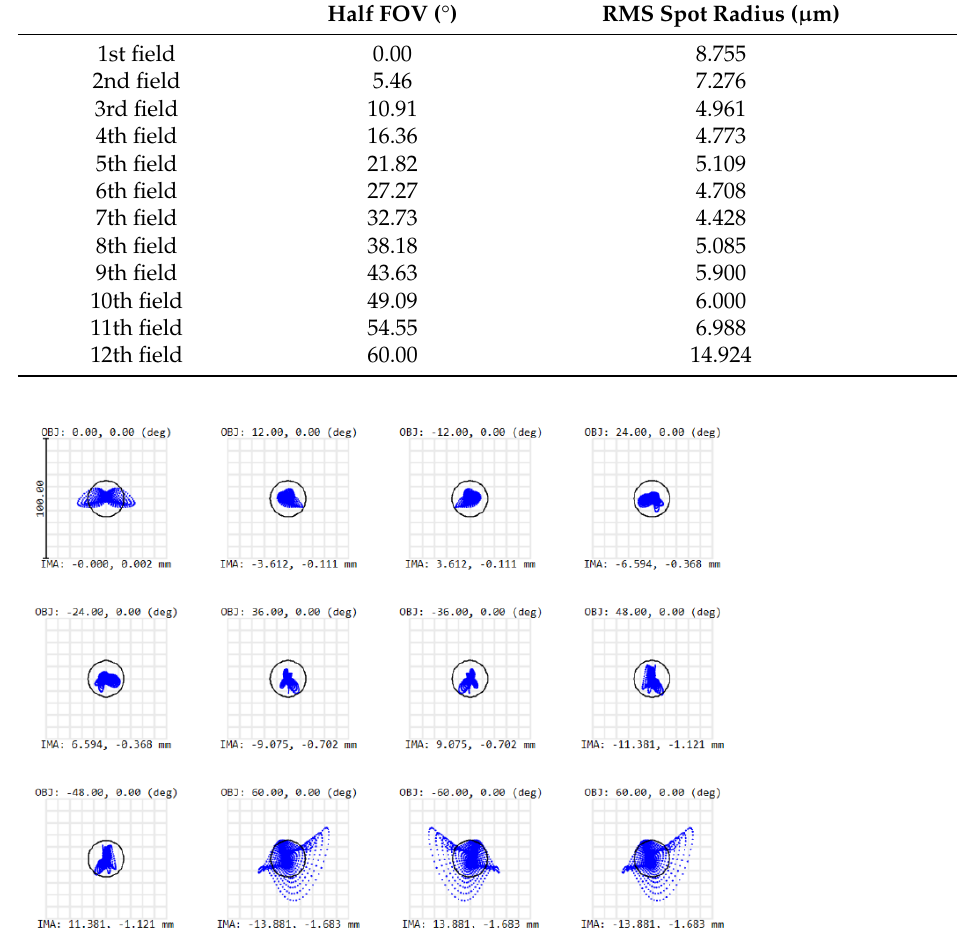
Figure 10. Spot diagram at 1700 nm over the full field of view. For each field, the root-mean-square size of the spot is smaller than the Airy disk (radius = 15 µm, indicated by the black circle), implying a diffraction-limited design. The results are shown for an equiangular sampling over the half field of view. Results are symmetrical for the other half part of the field of view. OBJ (in degrees) defines the object field, and IMA (in mm) defines the image height of the centroid on the